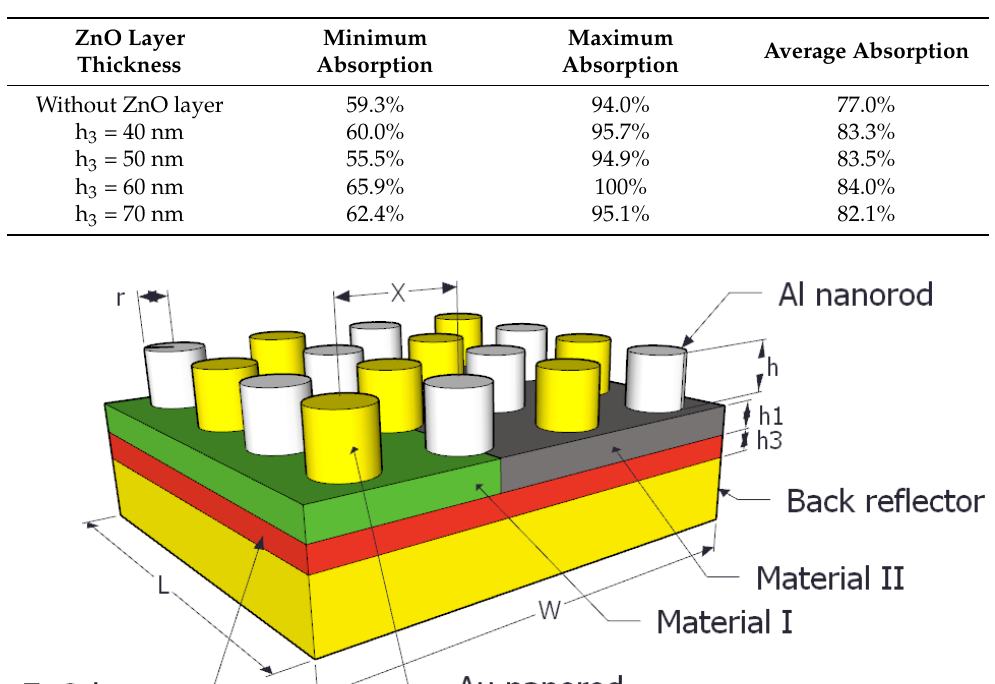
Figure 11. MMA side-by-side multi-dielectric layers structure with alternating nanorods distributed on ZnO substrate.